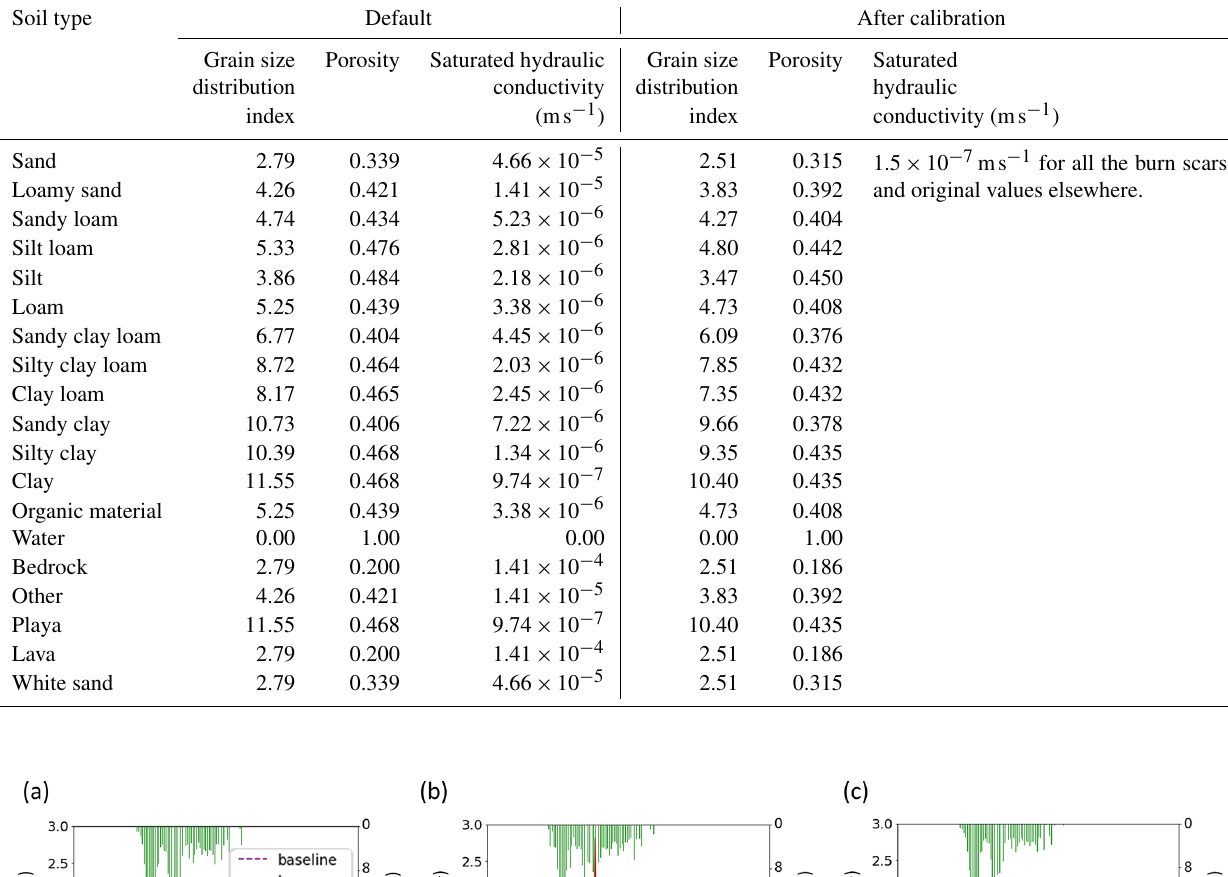
Table B3. Soil parameters in default and calibrated WRF-Hydro. Default soil parameters in WRF-Hydro are adapted from the soil analysis by Cosby et al. (1984). Grain size distribution index and soil porosity are altered from default values during the global soil moisture calibration. Saturated hydraulic conductivity is altered from default values during the streamflow calibration.